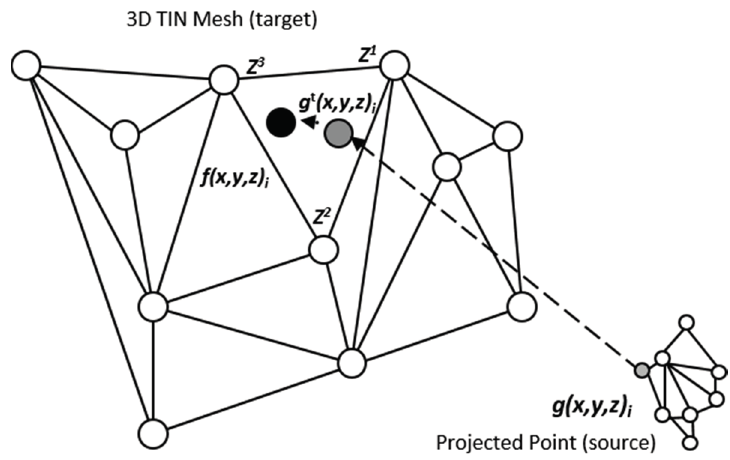
Figure 6. Schematic explanation of least squares target function minimization via perpendicularity constraints in grid-domain, ensuring closest point.